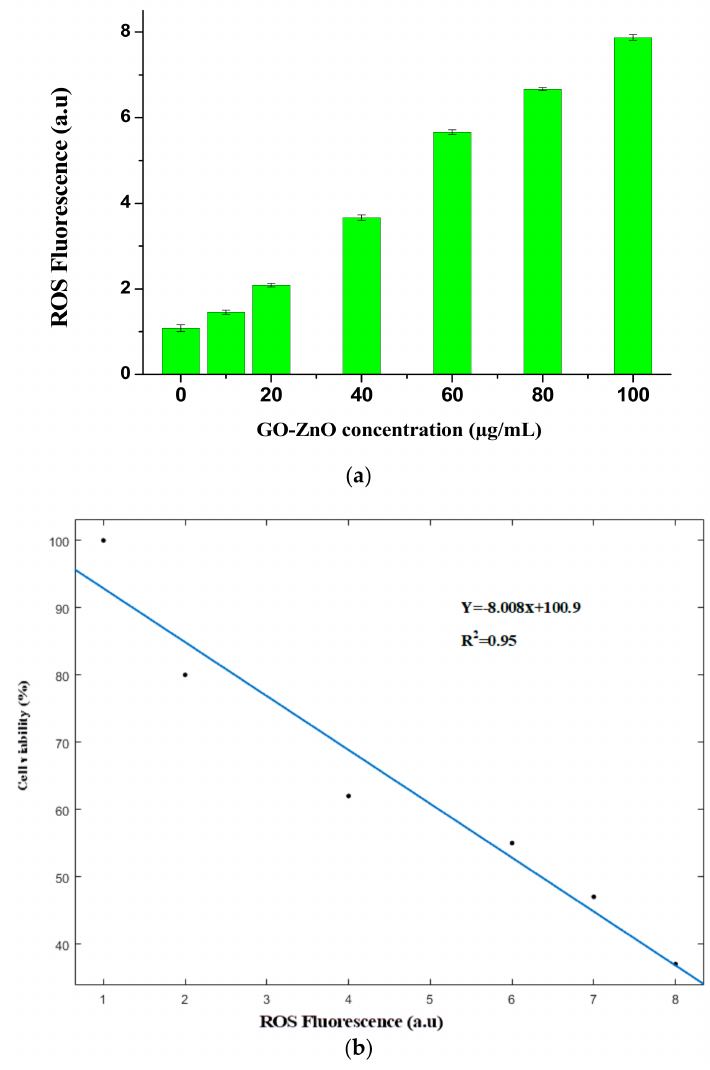
Figure 10. ( a ) GO-ZnO liberated Reactive Oxygen Species (ROS) Fluorescence in breast cancerous cells; ( b ) a significant negative correlation between ROS and Cell